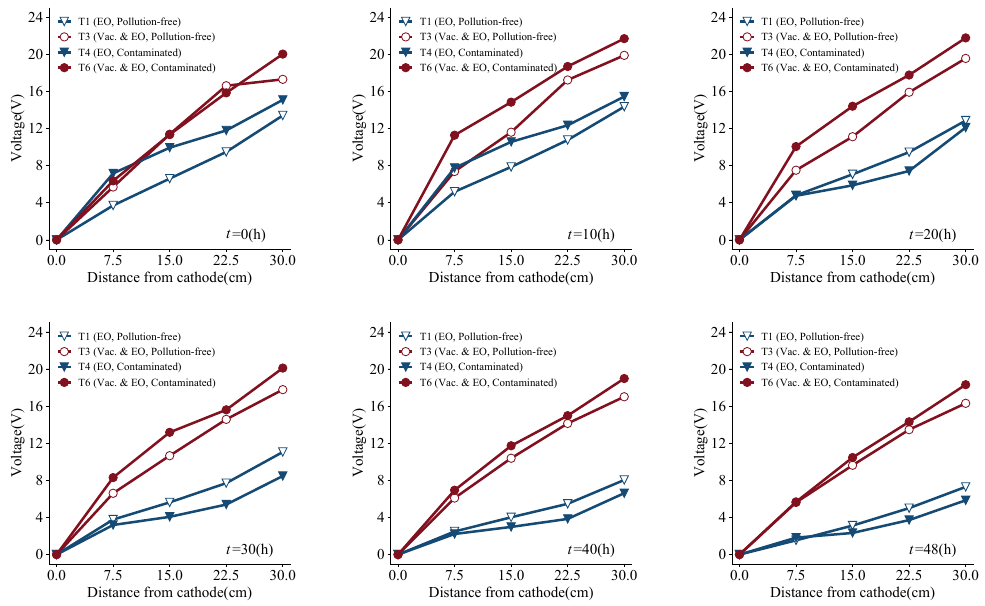
Figure 17. Voltage distributions at different